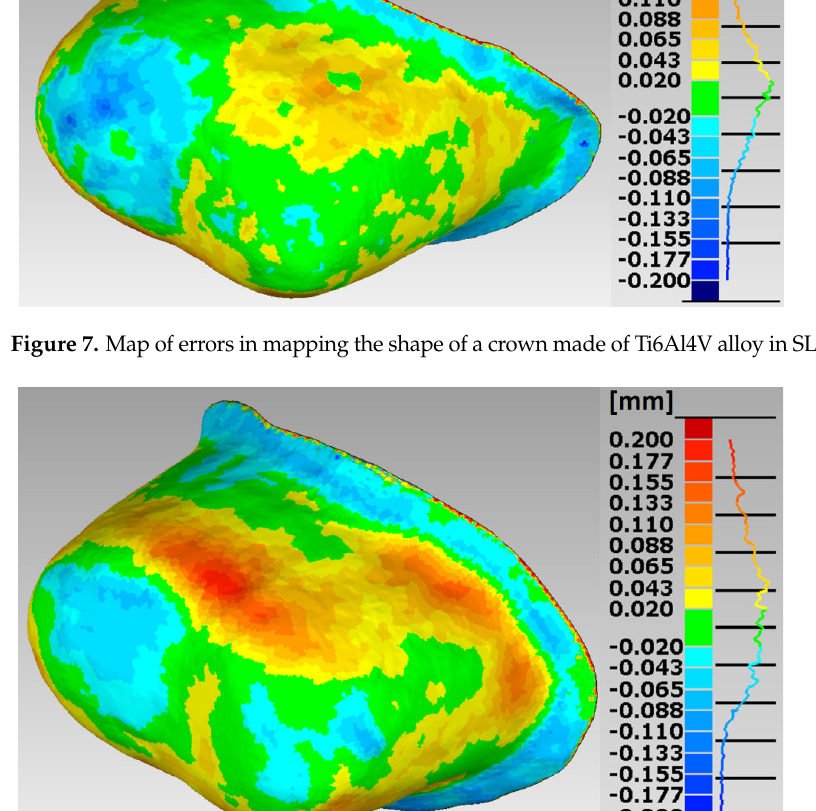
Figure 10. Map of errors in mapping the shape of a crown made of Ti6Al4V alloy in the milling for molar tooth 36. The errors in mapping the shape of crowns made of Ti6Al4V alloy with SLM are in the range: − 0.178 mm ÷ 0.200 mm for the premolar and − 0.138 mm ÷ 0.246 mm for the molar, and from the milling in the range: − 0.143 mm ÷ 0.200 mm for the premolar and from − 0.168 mm to 0.247 mm for a molar. The analyses of the reports, in the form of